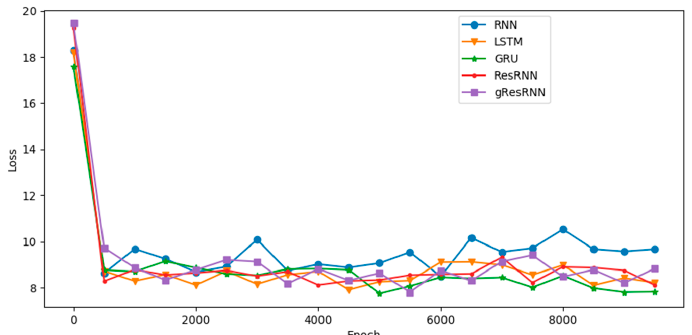
Figure 5. The losses for polyphonic databases of the RNN [9], LSTM [16] and GRU [17] and Res-RNN, Res-RNN with gates in 10,000 epochs.